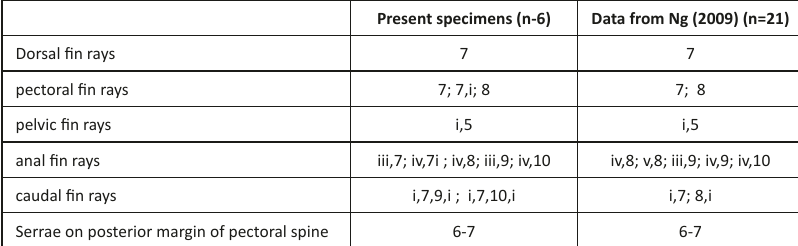
anal fin rays caudal fin rays Serrae on posterior margin of pectoral